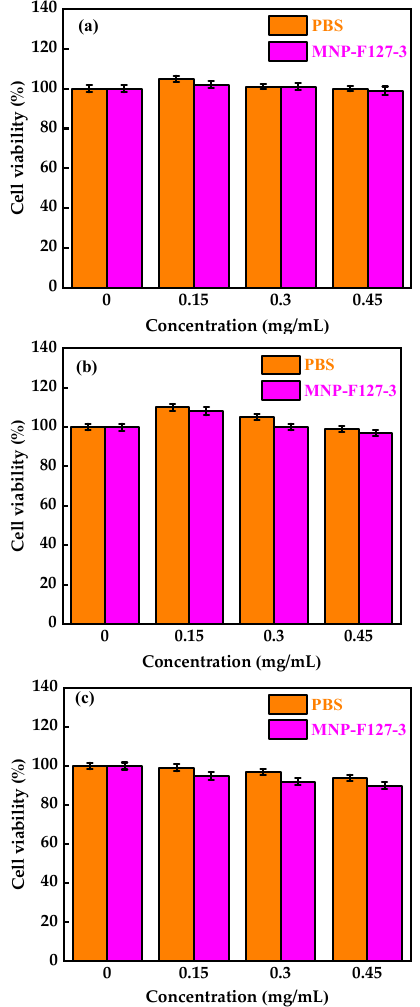
Figure 7. Cell viability of MNP-F127-3 and PBS over the HepG2 cell line at ( a ) 24, ( b ) 48, and ( c ) 72 h, respectively. Figure 7. CellviabilityofMNP-F127-3andPBSovertheHepG2celllineat( a )24,( b )48,and( c